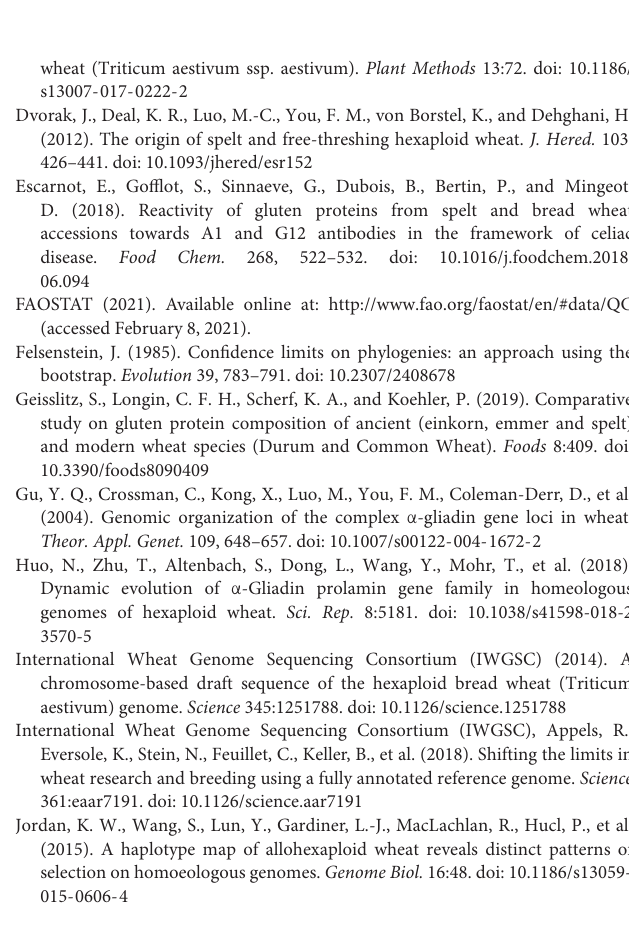
perpendicular to the diagonal, indicating that the large-scale structure of assemblies is correct. Dashed lines represent the position of each sub locus identified in Gli-B2 . Supplementary Figure 2 | Interchromosomal interactions between chromosomes 6B and 6D for each accession. Interactions between these chromosomes are weak apart from small regions that show dark vertical lines (e.g., in Jagger, Landmark, Mace), representing evidence of possible misassembly. Supplementary Figure 3 | Alignment of LongReach Lancer and CDC Landmark chromosome 6B to that of Chinese Spring (CS). In the region from 0 to 100 Mb on 6B, LongReach Lancer may have inversions compared with CS. On the other hand, though interrupted by assembly gaps and indels, the region is assembled in CDC Landmark with the same orientation as that in CS. Supplementary Figure 4 | Validation of the Gli-2 loci with long-read data. Oxford Nanopore Technologies long reads of CDC Landmark were aligned to the short read-based assembly of the same variety (Walkowiak et al., 2020). Alignments at the Gli-2 loci were inspected for overall structure [ (A) , Gli-A2a on chr6A 25.7–26.5 Mb] and at the single-gene scale [ (B) Gli-B2-1a on chr6B]. Despite the presence of assembly gaps, the sequence of the coding regions was well supported by multiple reads. Supplementary Table 1 | Gene copy name, chromosome with start and stop position, gene annotation (if available) from Walkowiak et al. (2020), and number of amino acids (if full length) information for all copies identified within the 11 accessions. Supplementary Table 2 | Posterior probabilities and estimated omega ( ω ) values for all amino acid sites in gliadin alignments for each subgenome analyzed separately and